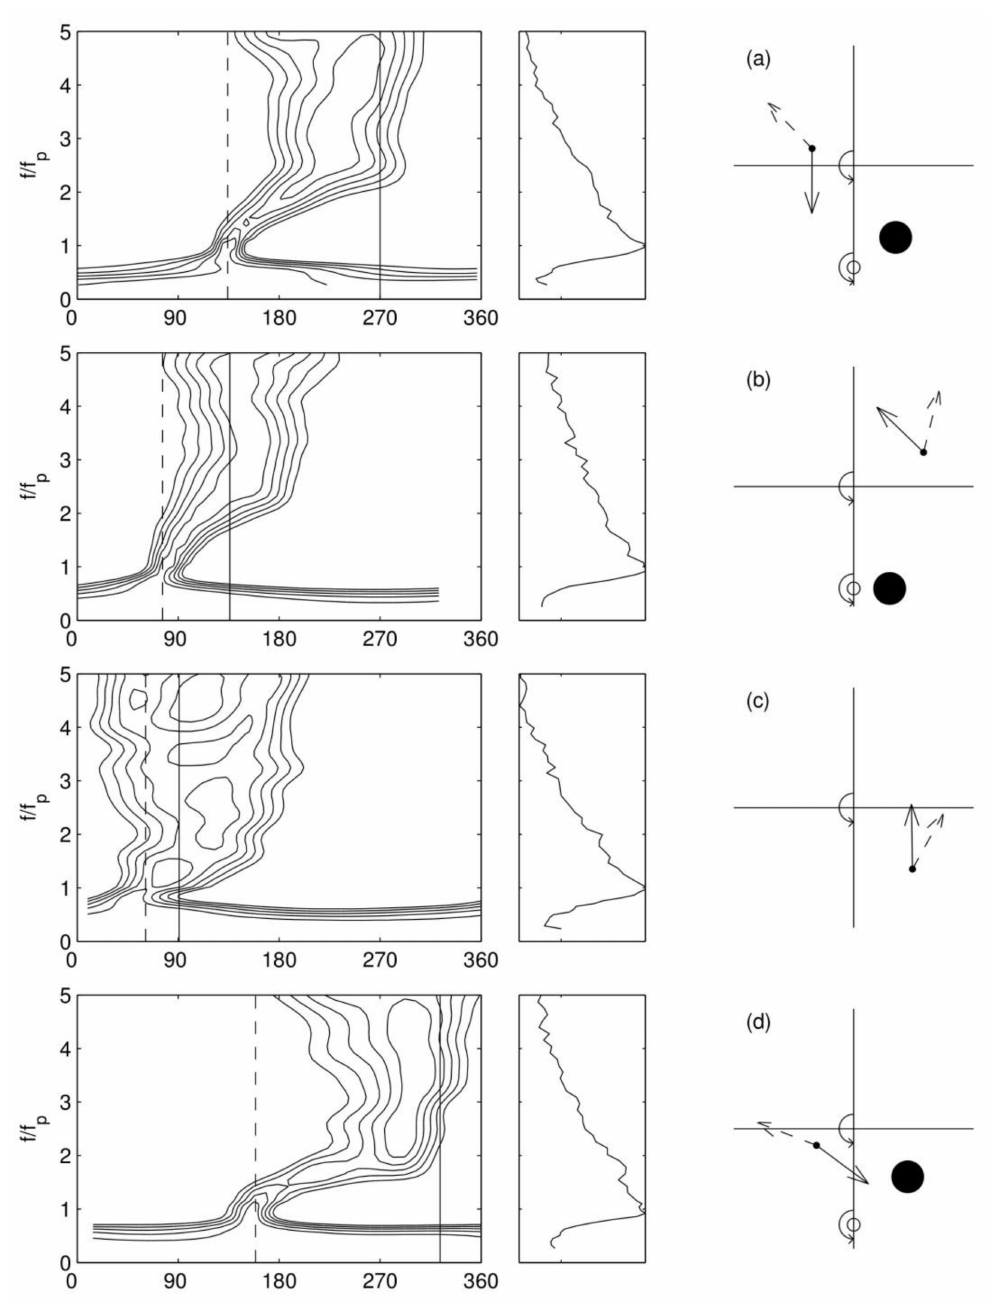
Figure 9. Examples of the directional spreading function, Equation (15) for each quadrant of a tropical cyclone [31] (( a ) Forward left quadrant, ( b ) Forward right quadrant, ( c ) Rear right quadrant, ( d ) Rear left quadrant). The panels to the left shows the directional spreading function and the central panels the corresponding one-dimensional spectrum. The panels on the right show the measurement location (solid dot), the tropical cyclone position (cross), the wave direction (dashed arrow), the local wind direction (solid arrow), and the likely position where the measured waves were generated (large solid